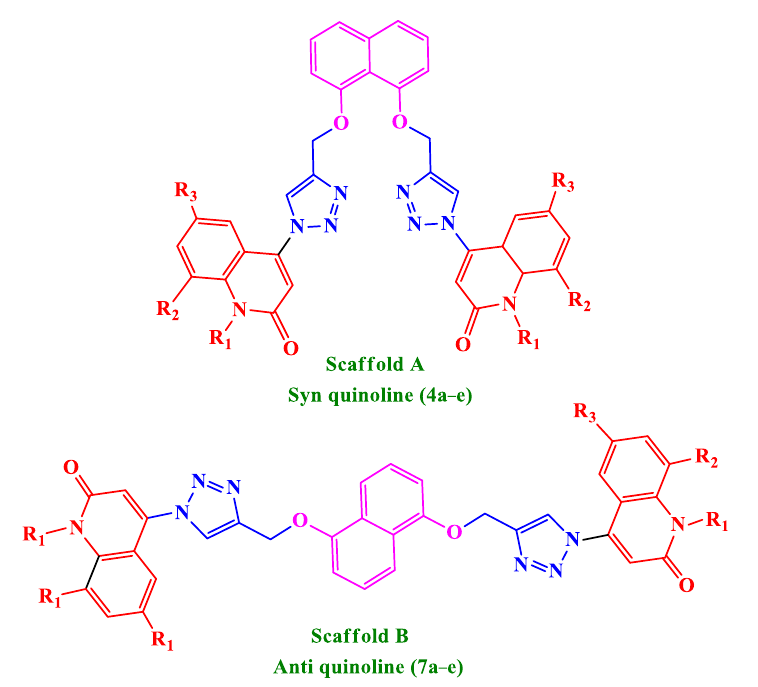
Figure 3. Structures of new quinoline-1,2,3-triazole hybrids 4a – e and 7a – e .